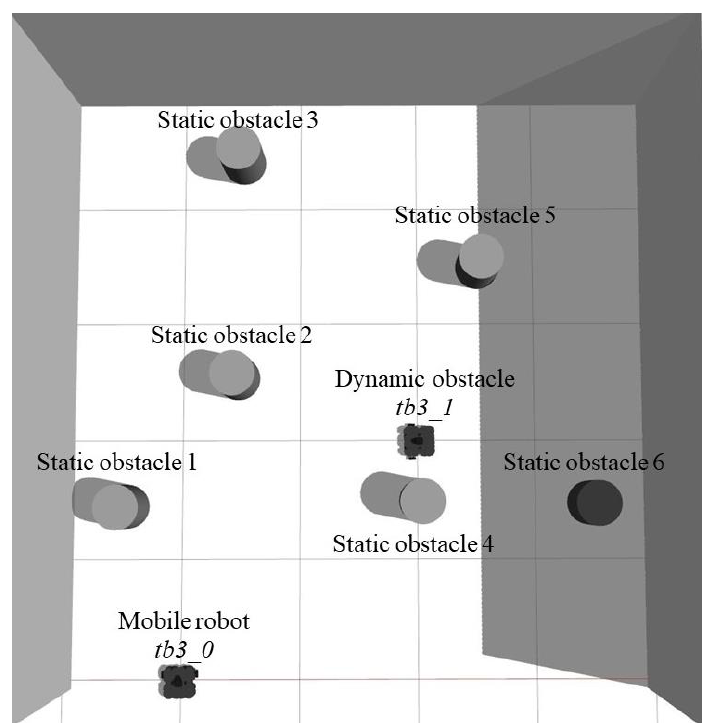
Figure 6. Simulated environment scenario 2 with labels.